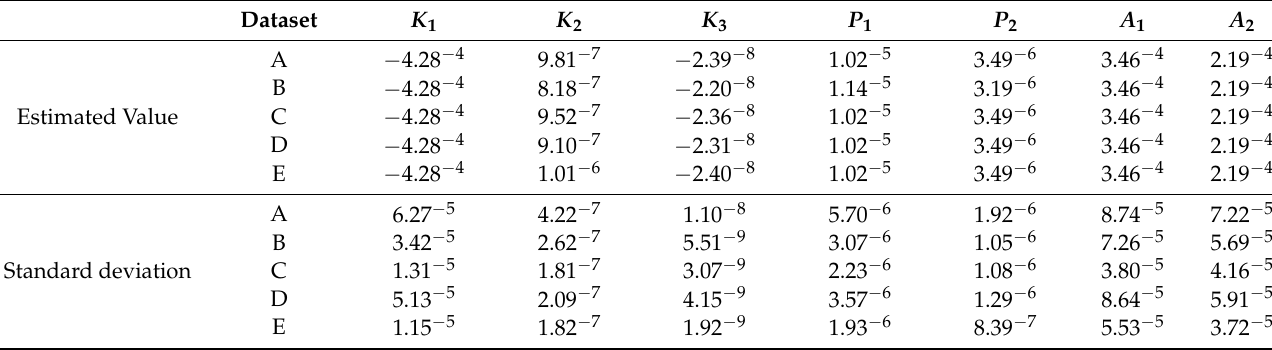
Table 12. Estimated values and standard deviations of lens distortion parameters in real experiments (camera 1).